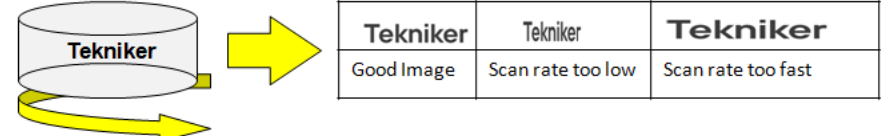
Figure 3. An illustration of scan rate not matching with moving speed.